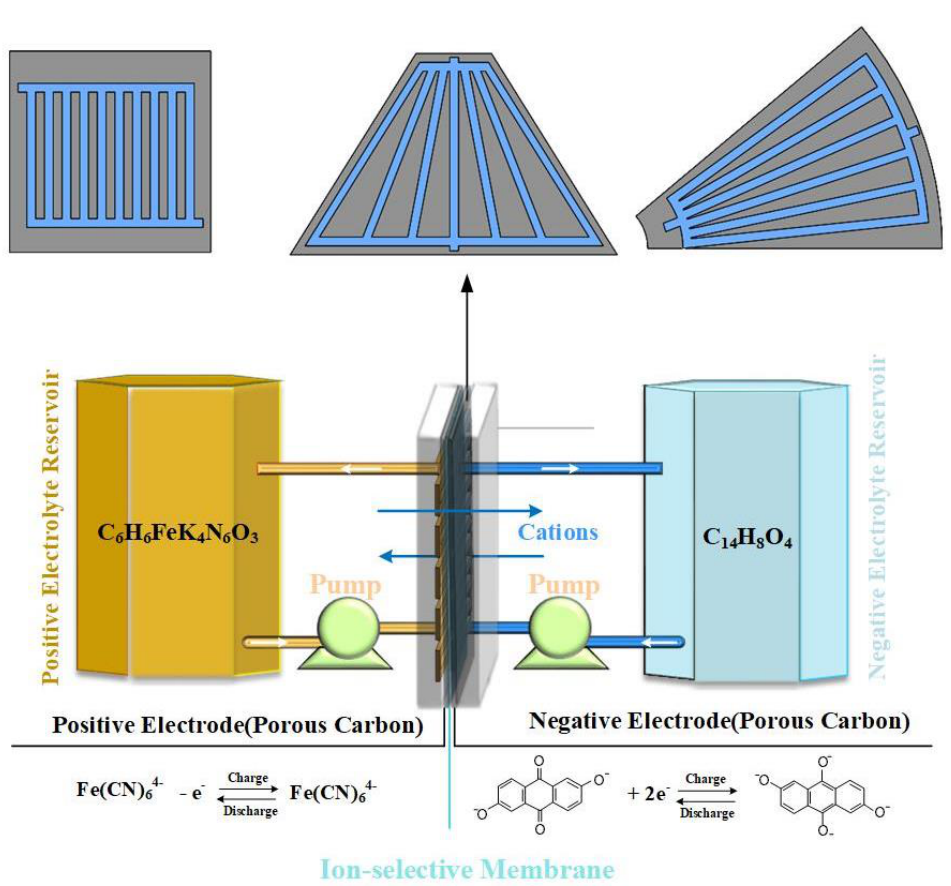
Figure 1. Schematic diagram of the organic flow battery and a three-dimensional sketch of the ferrocyanide-based ORFBs.